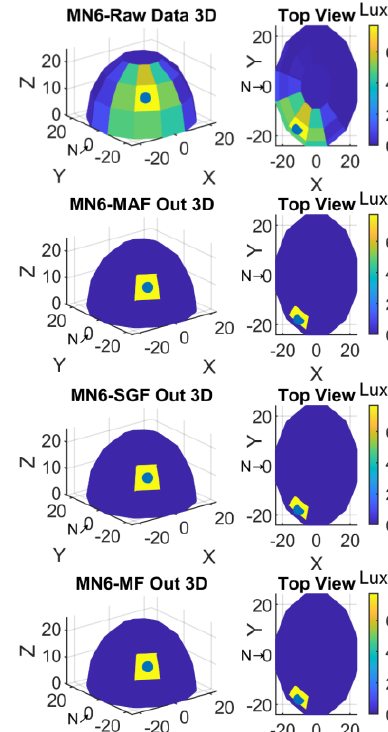
Figure 13. Spherical and top view of MN3 and MN4 experiment result. Graphic plots for the measurements from MN5 and MN6 were shown in Figure 14.